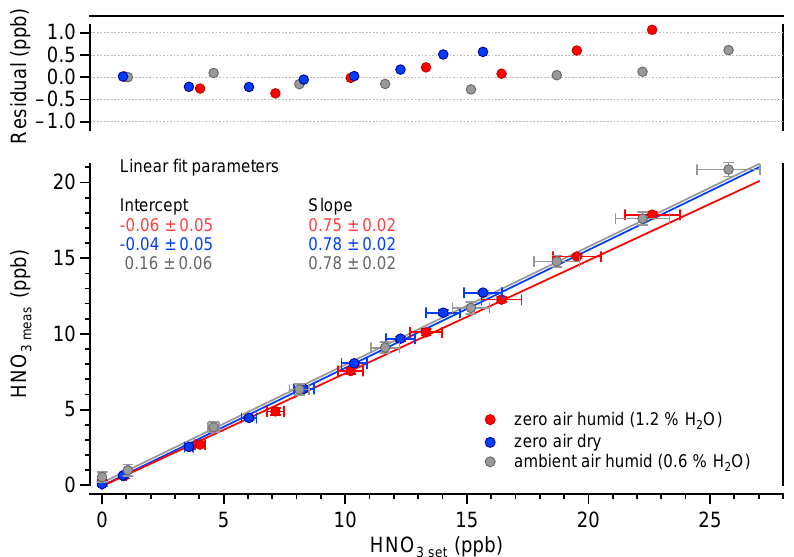
Figure 6. Measured HNO vs. calculated HNO amount fractions in various carrier gas conditions. 3 3 The fit parameters are given with their absolute uncertainties (k =